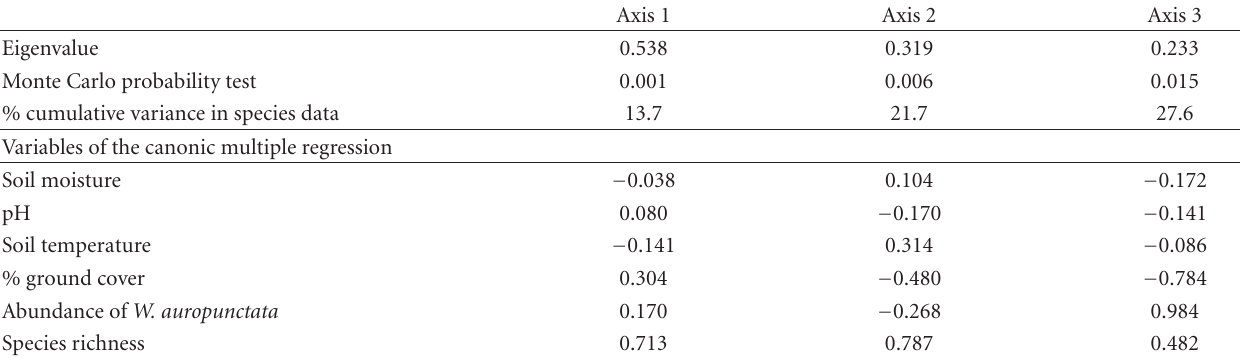
Table 3: Summary of the CCA statistics for each axis and the Monte Carlo significance test for the proper values (eigenvalues) based on 999